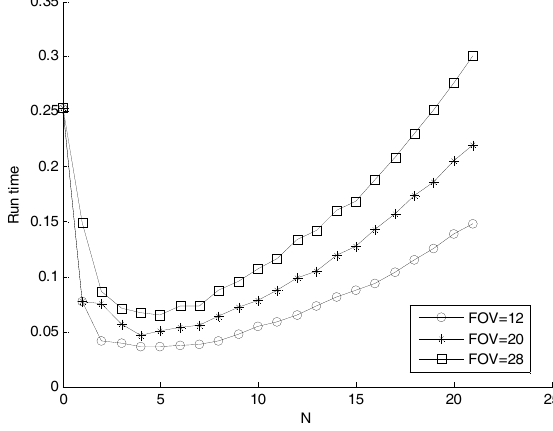
Figure 17. Tracking time for a real star sensor.